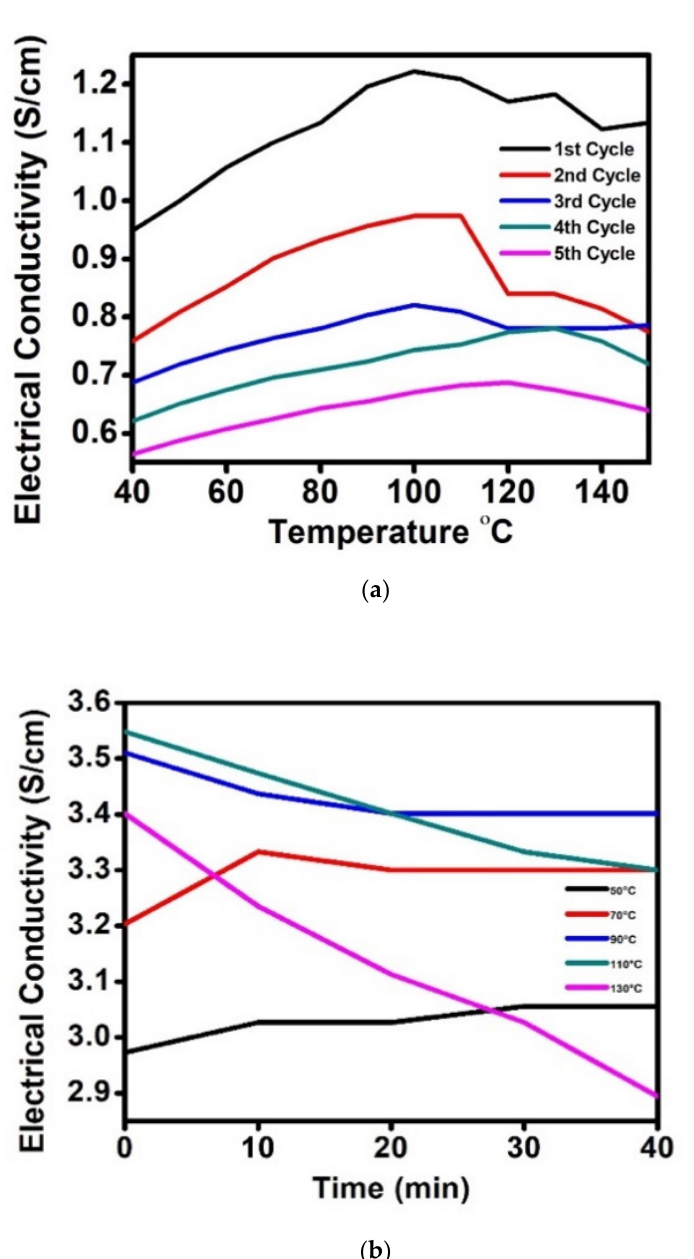
Figure 4. DC electricity conductivity retention by cyclic ( a ) and isothermal aging studies of Pani@g-C 3 N 4 ( b ).